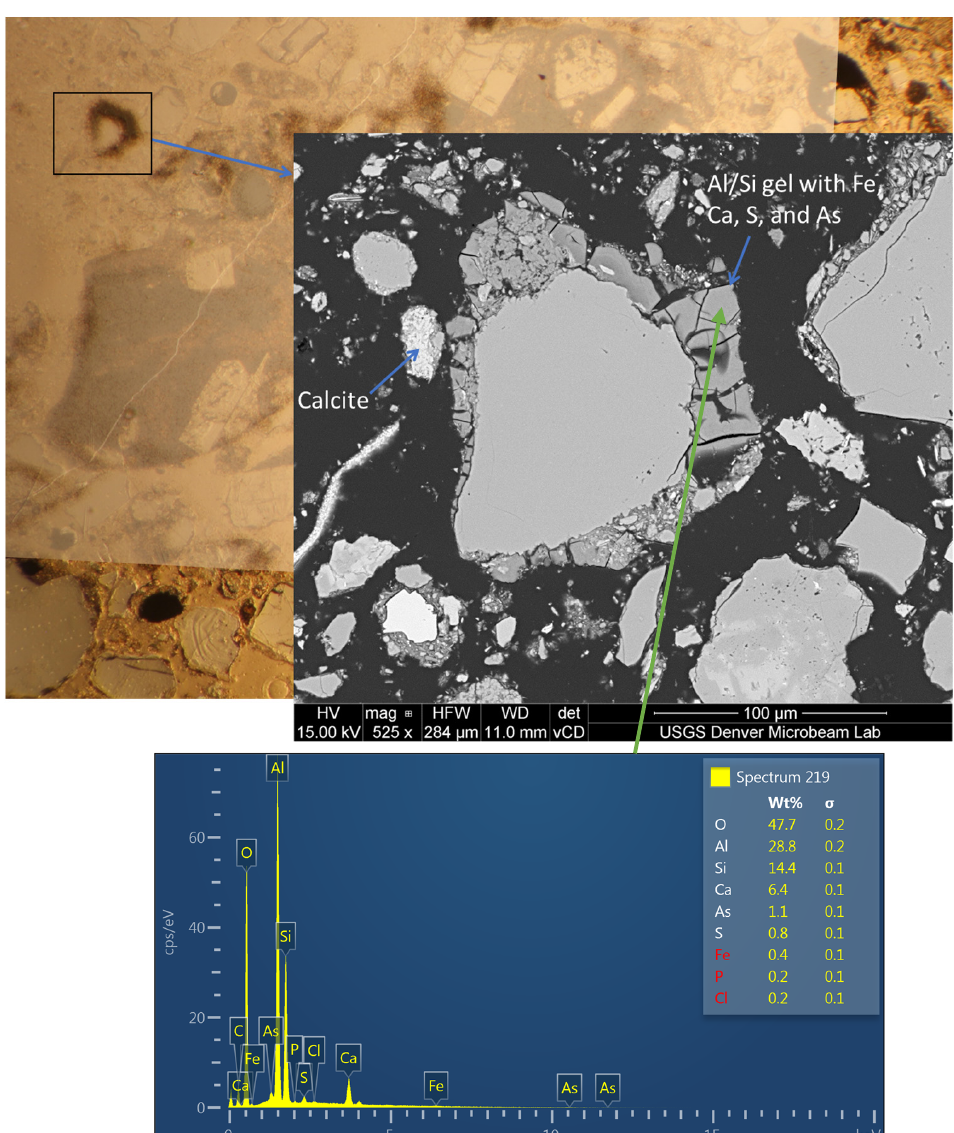
Figure 19. GJAST-20-10 area 13 (Figure 11), thin section plain light background with fission-track Figure 19. GJAST − 20 − 10 area 13 (Figure 11), thin section plain light background with fission-track overlay at 25% transparency with added SEM-BSE and spectrum overlay at 25% transparency with added SEM-BSE and spectrum images.